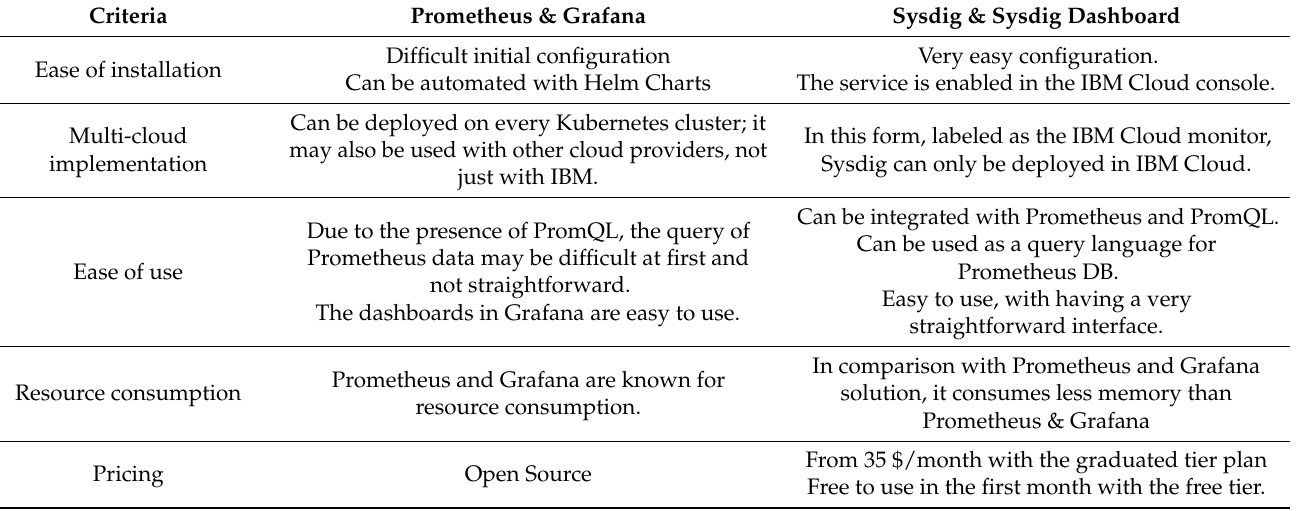
Table 1. Prometheus vs.